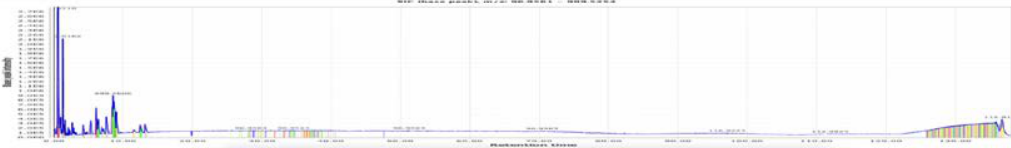
Fig. 5. Extracted ion chromatogram (XIC) of hot water crude extract of G. boninense after peak deconvolution by local minimum search. Each individual recognized peak within the chromatogram is indicated in different colour with peak intensity and m/z